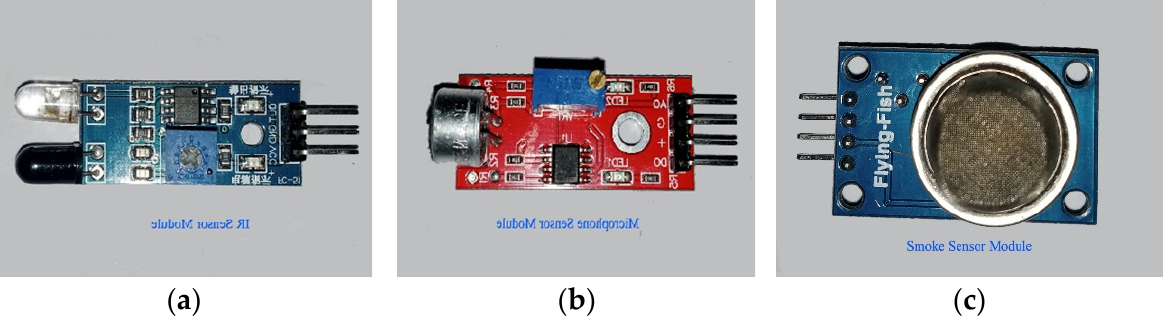
Figure 5. ( a ) IR sensor module [55]; ( b ) microphone sensor module [60]; ( c ) smoke sensor module